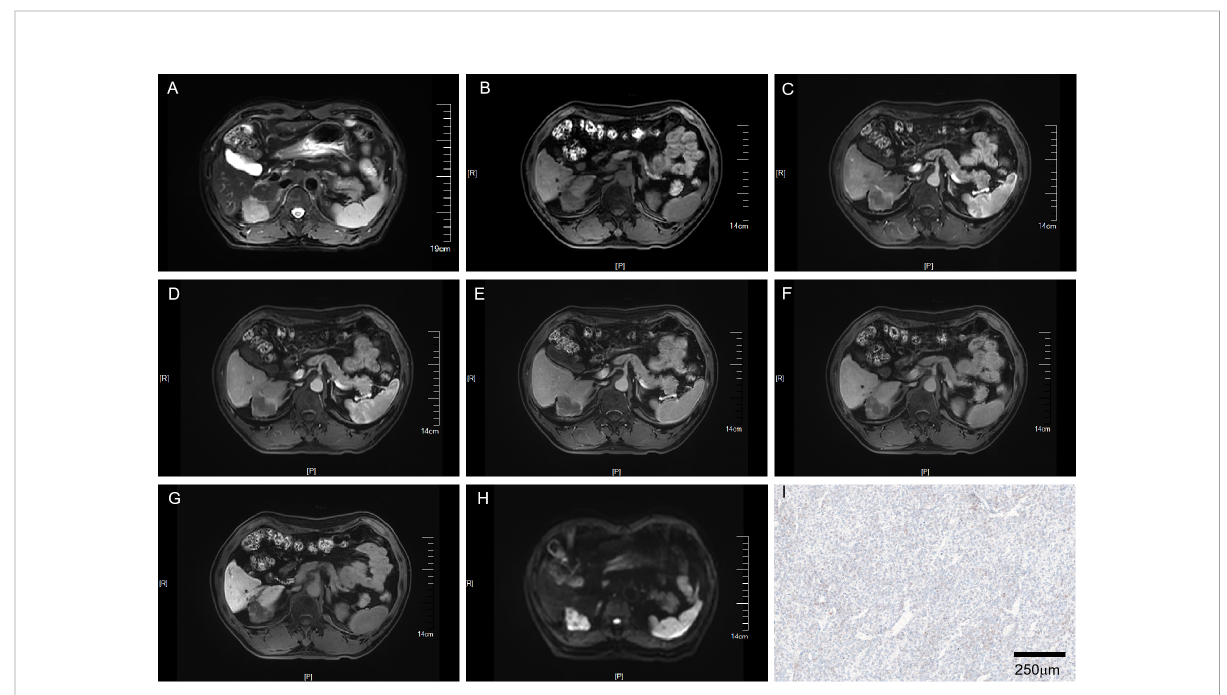
FIGURE 3 MRI of a VEGFR2-negative HCC patient with LI-RADS 3. Patient summary: a 59-year-old man with HCC in the right lobe of the liver, AFP level 2.7ng/ml, lesion dimension on MRI 3.8cm, and LI-RADS score of 3. (A) Axial T2-weighted MRI. (B) Axial T1-weighted MRI. (C, D) Early (15s) and late arterial phase (25s). (E) Portal venous phase (1min). (F) Delay phase (3min). (G) Hepatobiliary phase (15min). (H) Axial diffusion-weighted MRI. (I) VEGFR2-negative in pathology. MRI, magnetic resonance imaging; LI-RADS, liver imaging reporting and data system; AFP, alpha-fetoprotein; VEGFR2, vascular endothelial growth factor receptor